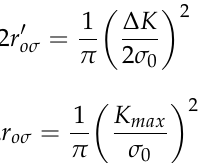
Table 3. Measurement results and theoretical results of CPZ in Q&P980 steel .